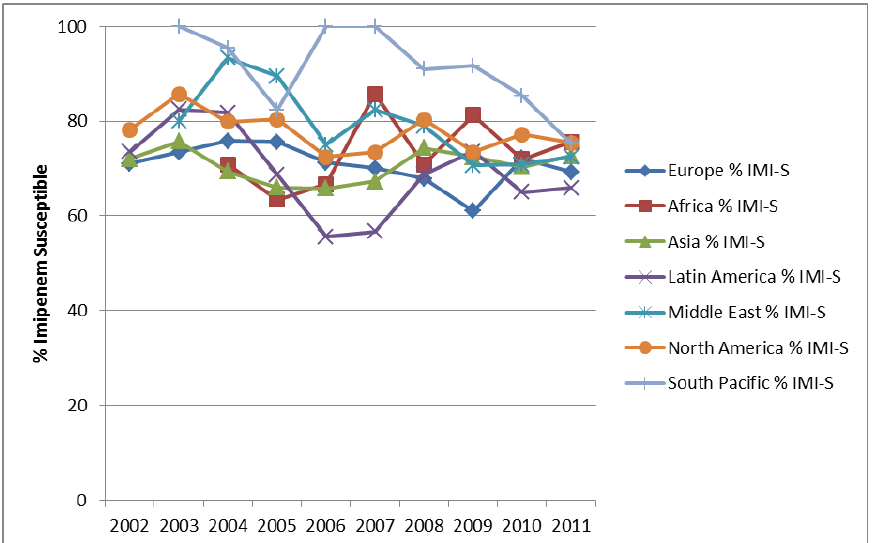
Figure 8. Susceptibility of P. aeruginosa from intra-abdominal infections to imipenem (IMI-S) by region from SMART 2002 to 2011.